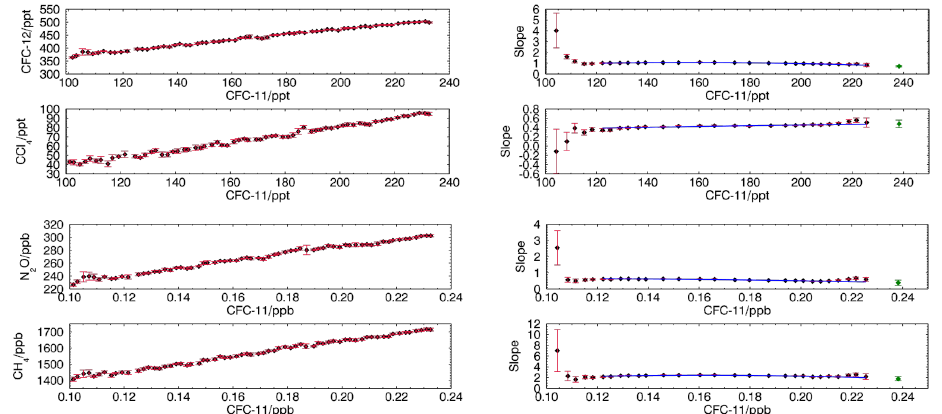
Figure B8 Correlations between the volume mixing ratios of CFC-12, CCl 4 , CH 4 and N 2 O and CFC-11 for the data from the northern hemisphere during the stratospheric winter of 2007. Left panels: The mean correlation profile. Each point represents the mean of the VMR in a window of 2 ppt of CFC-11. The error on these points is the standard deviation of the data within each 2 ppt window. Right panels: The local slope of data in an 80 ppt of CFC-11 window. The error on the points is the fitting error of this fit. The blue line is a second degree polynomial fit to the local slopes. The green point is the extrapolated slope at the tropopause.